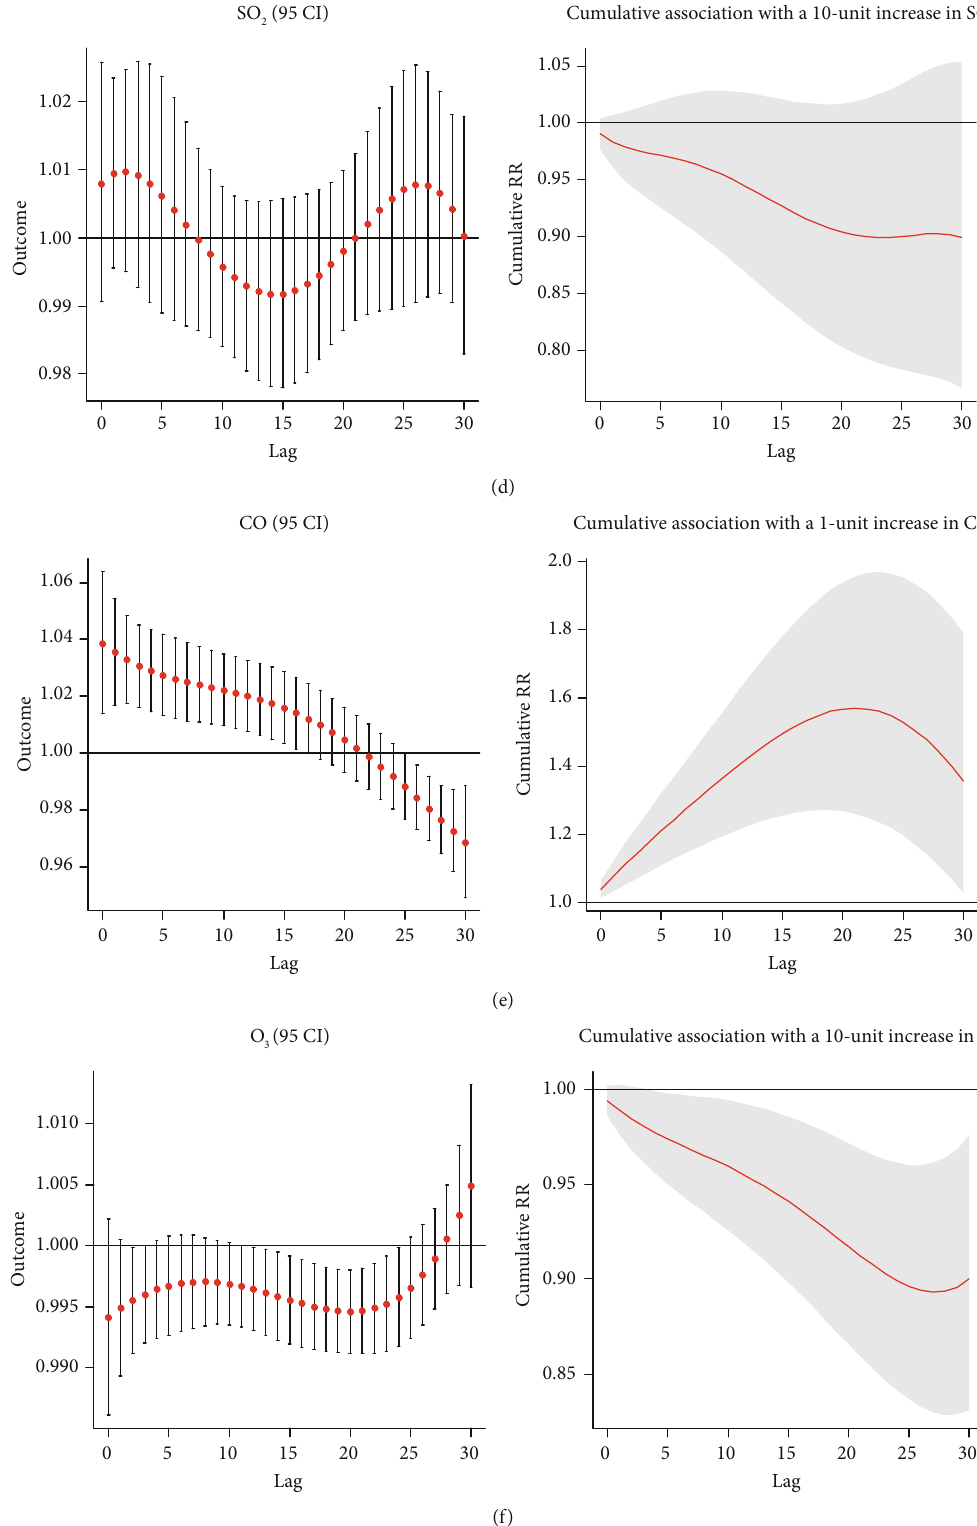
Figure 4: Hysteresis and cumulative e ff ect of air pollutants on the incidence of diabetes in single-pollutant model ((a) PM NO , (d) SO , (e) CO, and (f) O 2 2